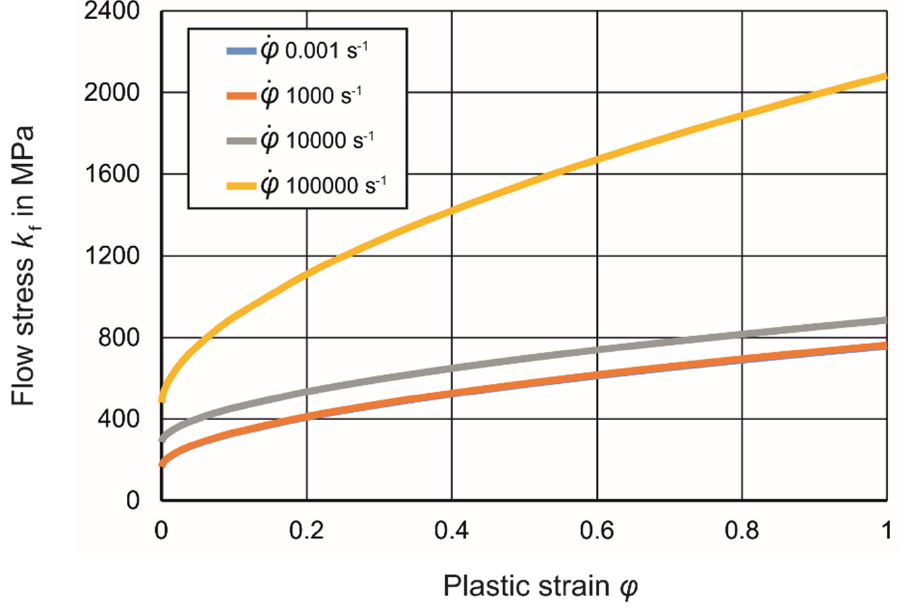
Figure 6. Implementation of the model proposed by Kabirian [24] to determine strain-rate-dependent flow curves for EN AW-5083, 𝜑(cid:4662) represents the strain rate in 1/s.